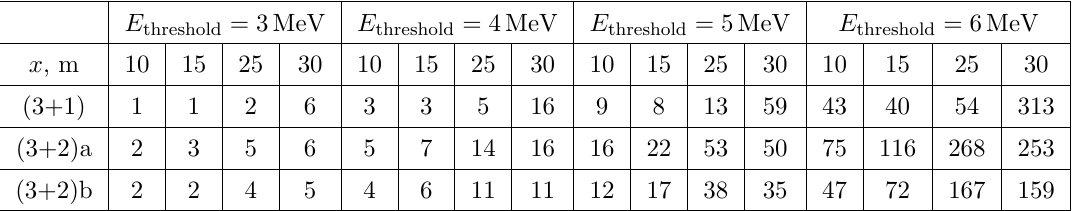
Table 1 . Duration of the experiment (in days) for disfavoring of no oscillation hypothesis at C.L.=99% for three models [(3+1), (3+2)a and ((3+2)b] at di(cid:11)erent thresholds ( E threshold = 3, 4, 5 and 6 MeV) and position of the detector x = 10, 15, 25 and 30